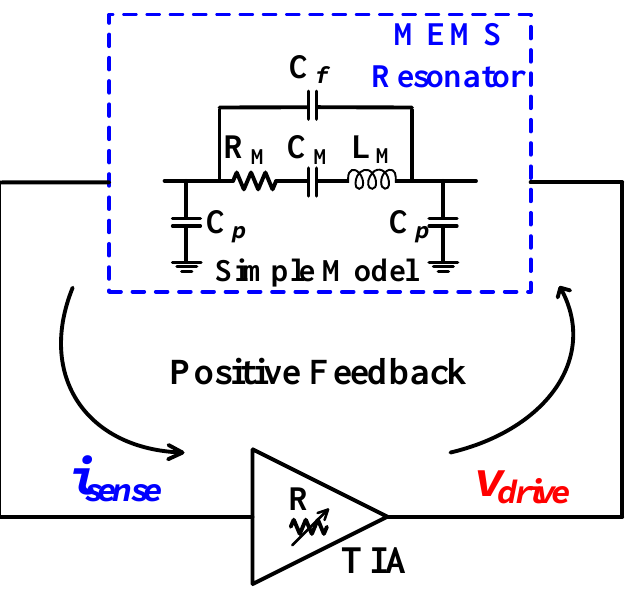
Figure 1. MEMS-based series resonant